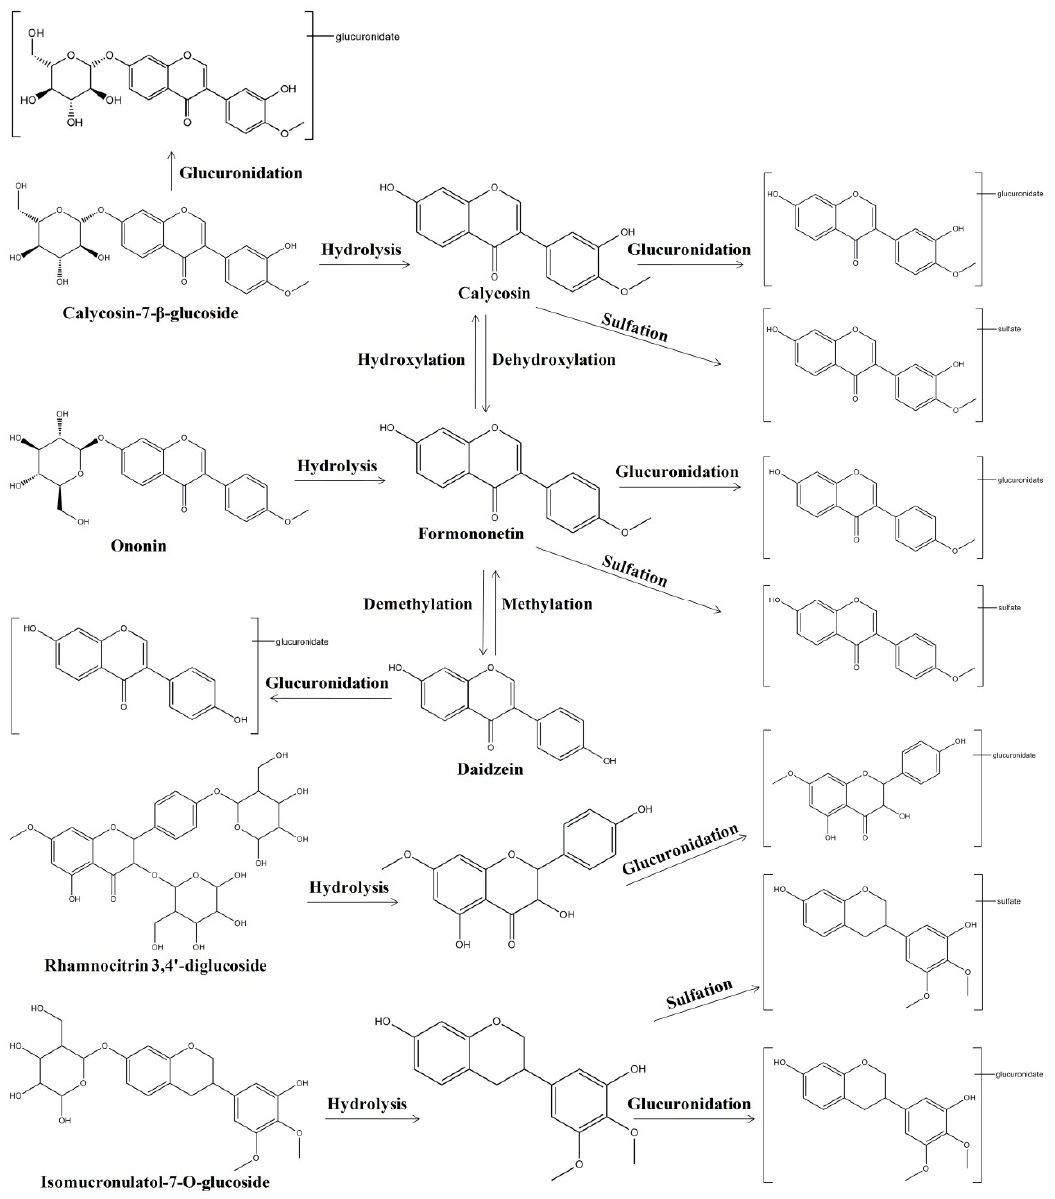
Figure Figure 7. Proposed pathways of metabolism and biotransformation of the compounds after administration of AR extracts in vivo.